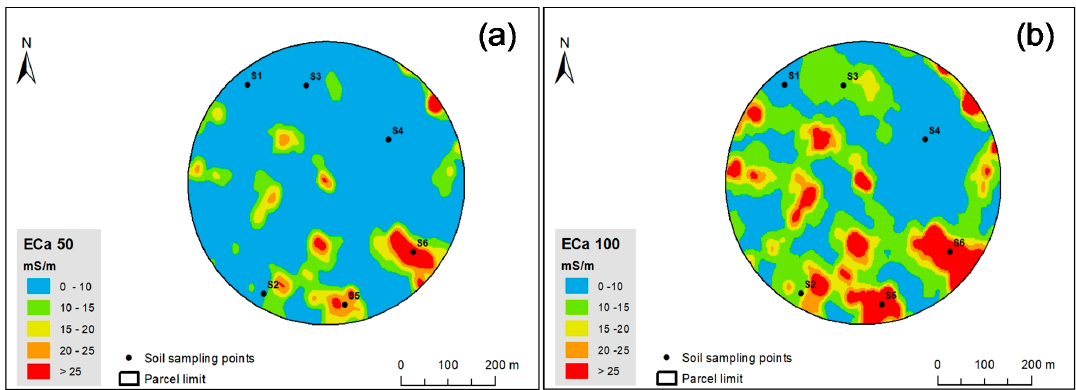
Figure 4. Corn yield map of a “Eucalyptus” field in October 2016.